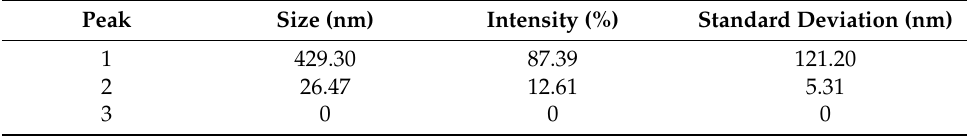
Table 3. Particle size distribution from the DLS measurements.